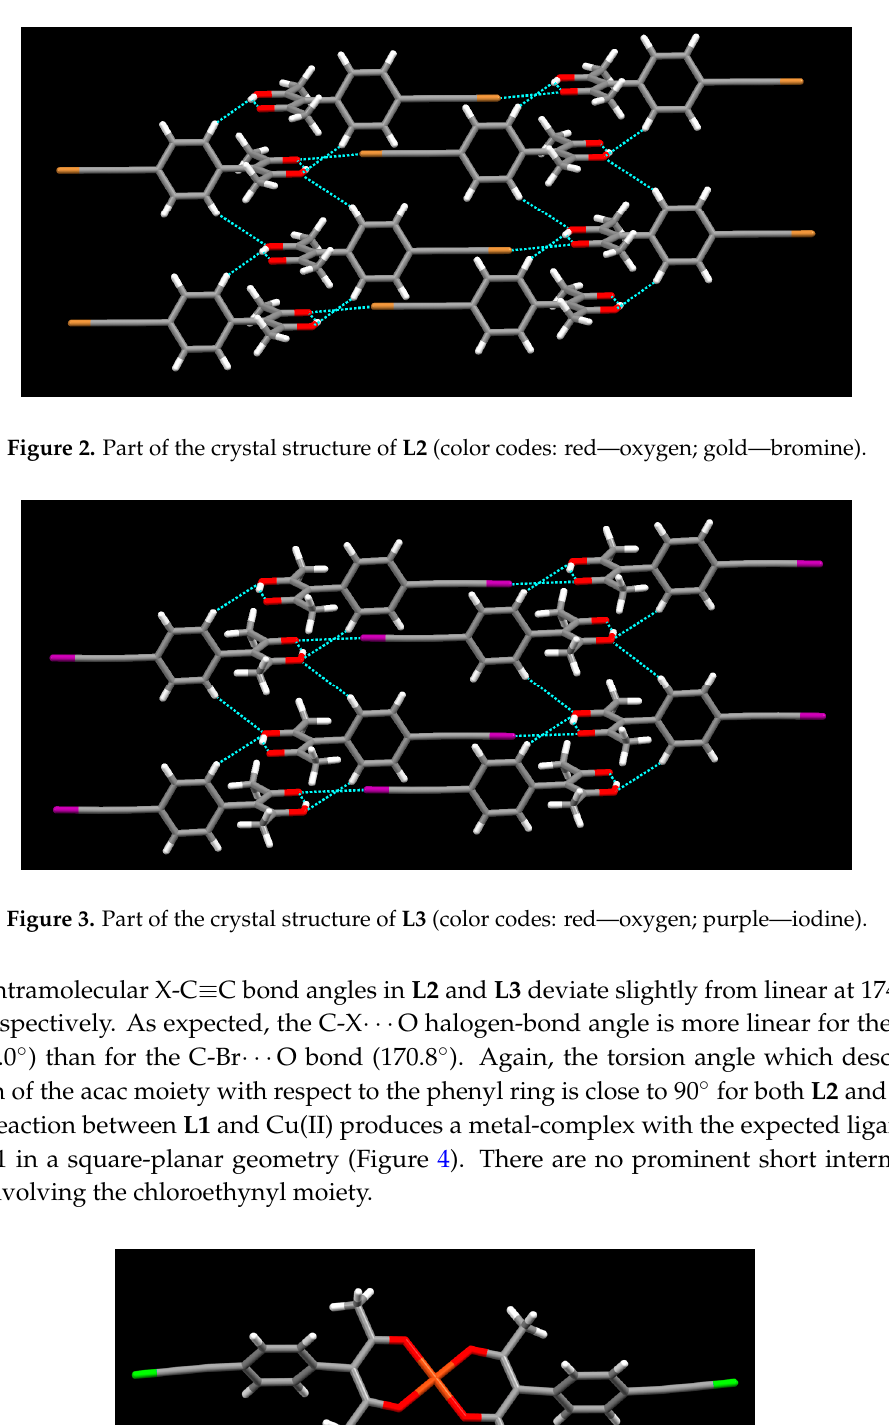
Figure 4. The geometry of the complex ion in the crystal structure of [Cu( L1 ) 2 ] (color codes: red—oxygen; green—chlorine; orange—copper).